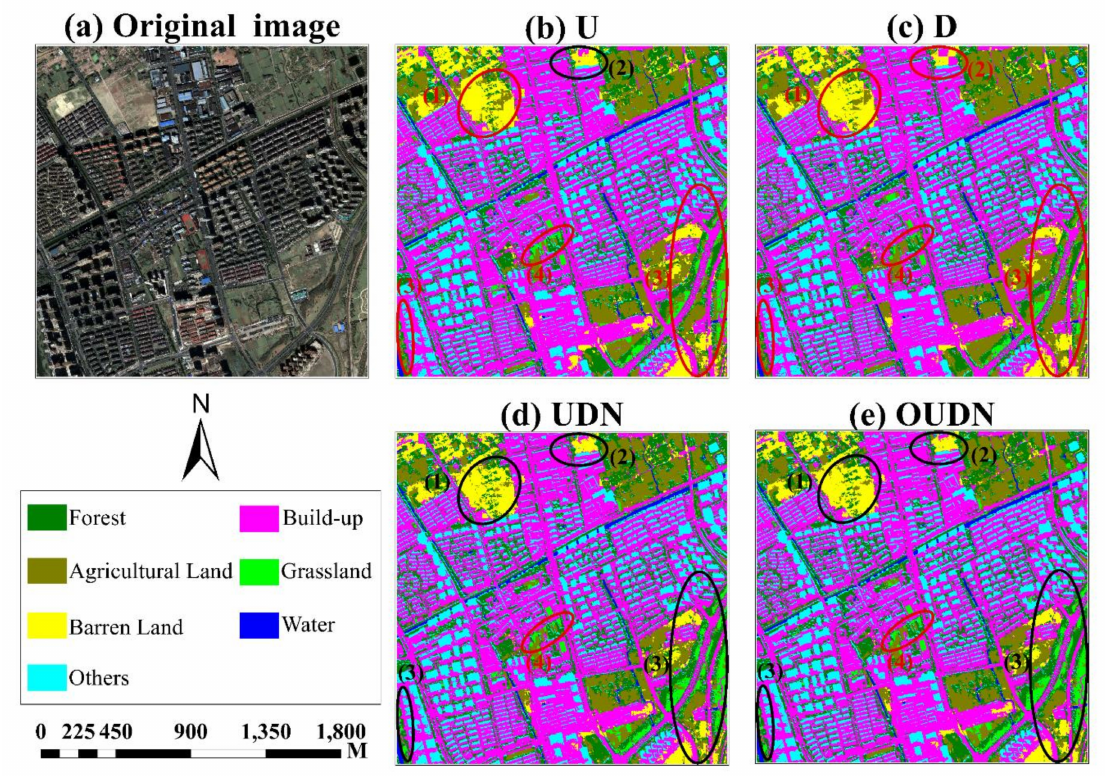
Figure 10. ( a ) Original image; ( b ) the classification map of the U algorithm based on the Spe-Texture; ( c ) the classification map of the D algorithm based on the Spe-Texture; ( d ) the classification map of the UDN algorithm based on the Spe-Texture; ( e ) the classification map of the OUDN algorithm based on the Spe-Texture; and the red and black circles denote incorrect and correct classifications,